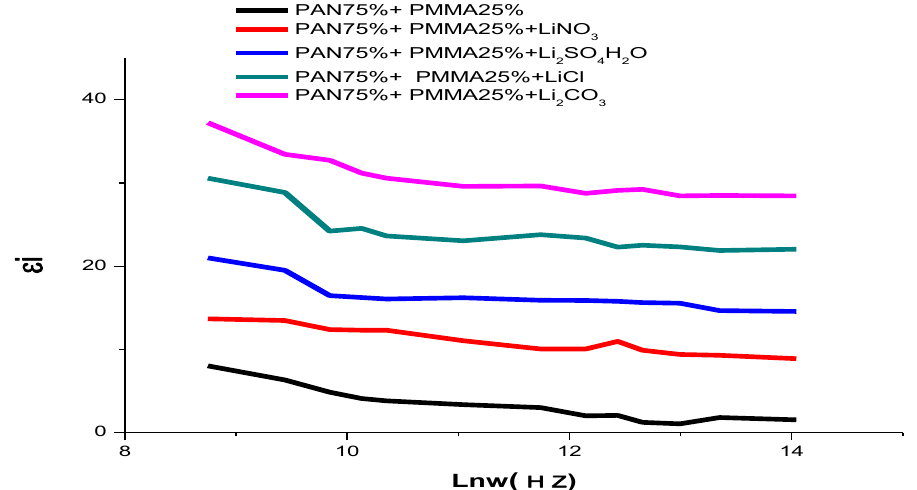
Figure 3b: The imaginary dielectric constant as function of ln (ω) of undoped (75%PAN+25%PMMA) and doped with 20% (Li